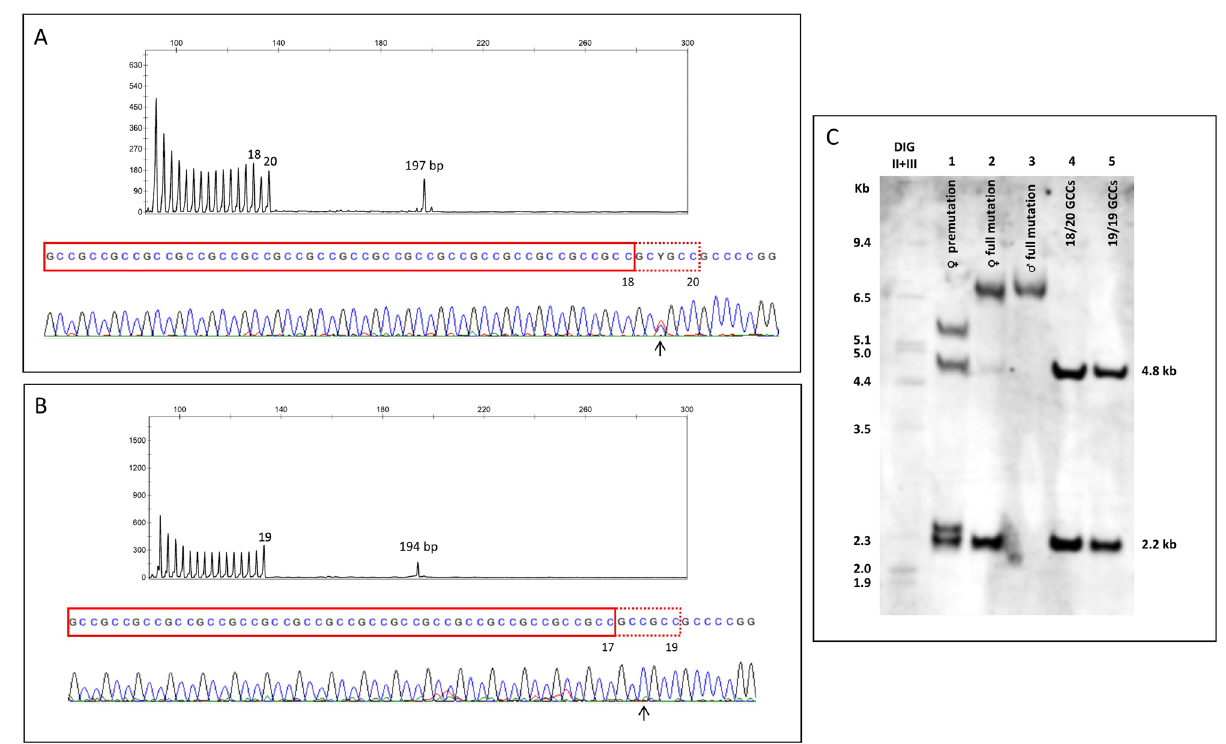
Figure 2. Examples of atypical results. TP-PCR electropherograms, sequencing and Southern blot of samples where TP-PCR profile sizing differs from that of the total repeat length. ( A ) Female sample showing 18 and 20 GCCs TP-PCR profile and a 197 bp total length peak; c.-413T > C heterozygous genotype (arrow); normal Southern blotting result (C-lane 4); ( B ) Female sample showing 19 GCCs and a 194 bp total length peak; c.-413T > C homozygous genotype (arrow); normal Southern result (C-lane 5); ( C ) Lane 1, premutation female sample banding pattern: normal (2.2 and 4.8 kb), premutation (2.2 kb+) and a fragment with 5.4 kb due to the loss of an AflIII restriction site (NG_016313.1g.2379G > C heterozygous, rs5980369 highest population MAF: 0.169); Lanes 2 and 3, full-mutation female and male carriers, respectively (for details see Supplementary Fig. 1); Lanes 4 and 5, Normal female samples with 18/20 GCCs and 19/19 GCCs,